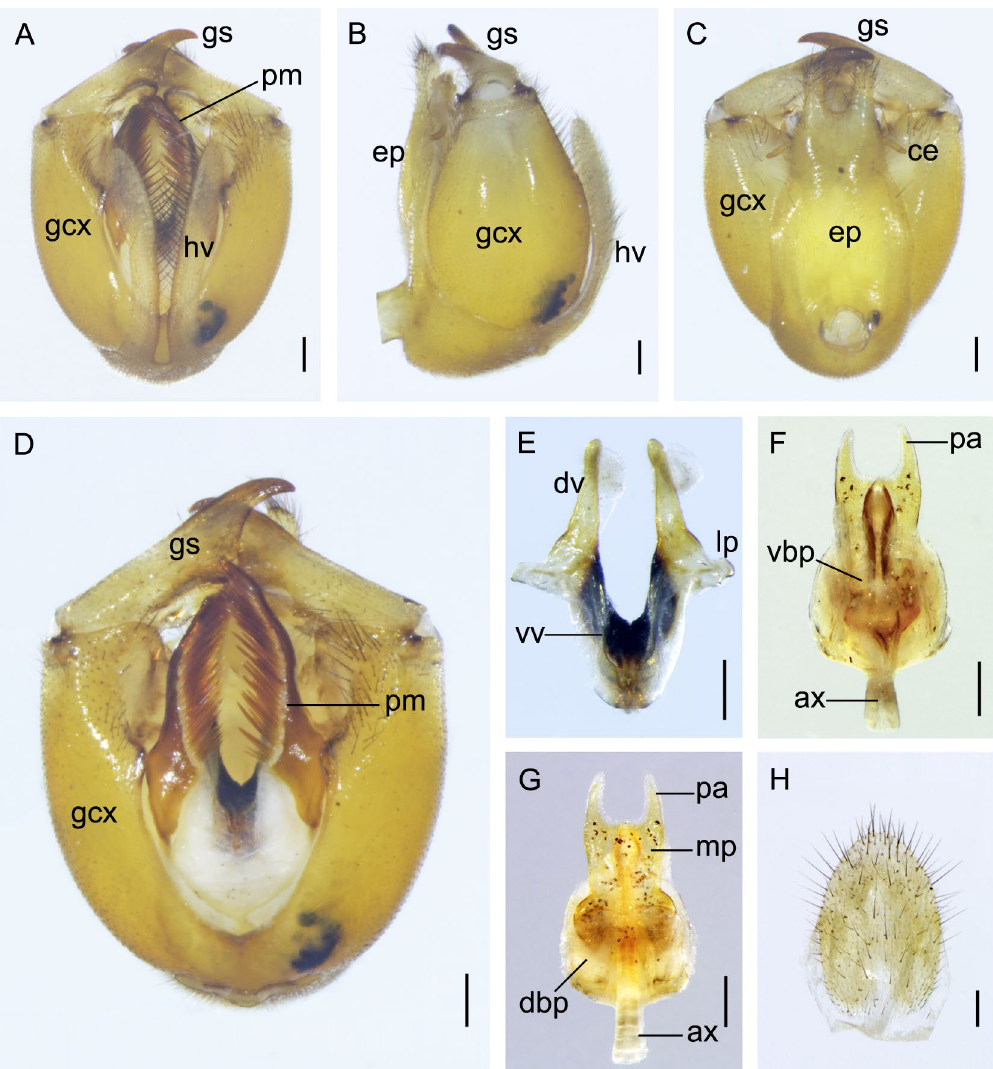
Fig. 6. Genitalia of Cerapanorpa baimaensis sp. nov. A–C . Male genital bulb in ventral, lateral, and dorsal views. D . Male genital bulb with hypandrium removed in ventral view. E . Aedeagus in ventral view. F–G . Female medigynium in ventral and dorsal views. H . Female subgenital plate in ventral view. Abbreviations: ax = axis; ce = cercus; dbp = dorsal basal plate; dv = dorsal valve; ep = epandrium; gcx = gonocoxite; gs = gonostylus; hv = hypovalve; lp = lateral process; mp = main plate; pa = posterior arm; pm = paramere; vbp = ventral basal plate; vv = ventral valve. Scale bars: 0.2